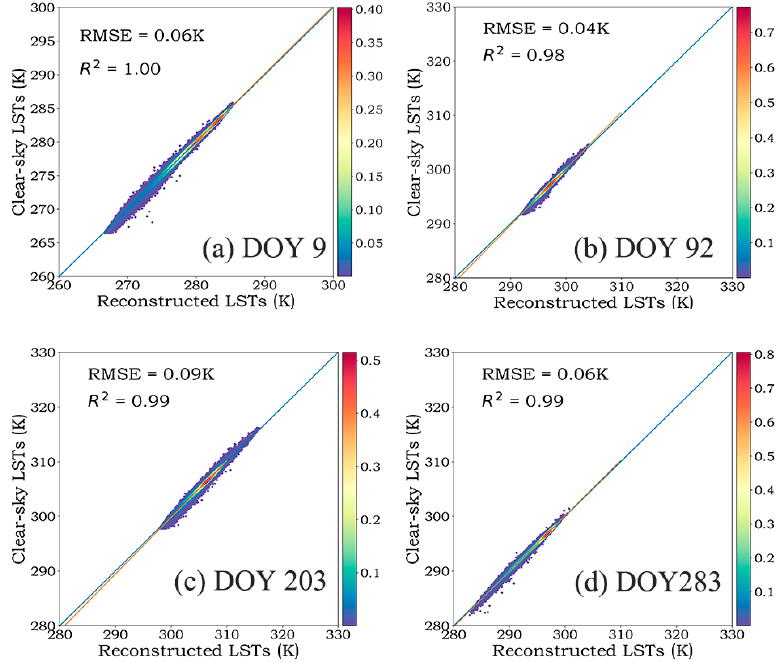
Figure 7. Model accuracy on four days in 2018 (DOY 9, DOY 92, DOY 203 and DOY 283). Table 1. The average variable importance scores of the reconstructed days.